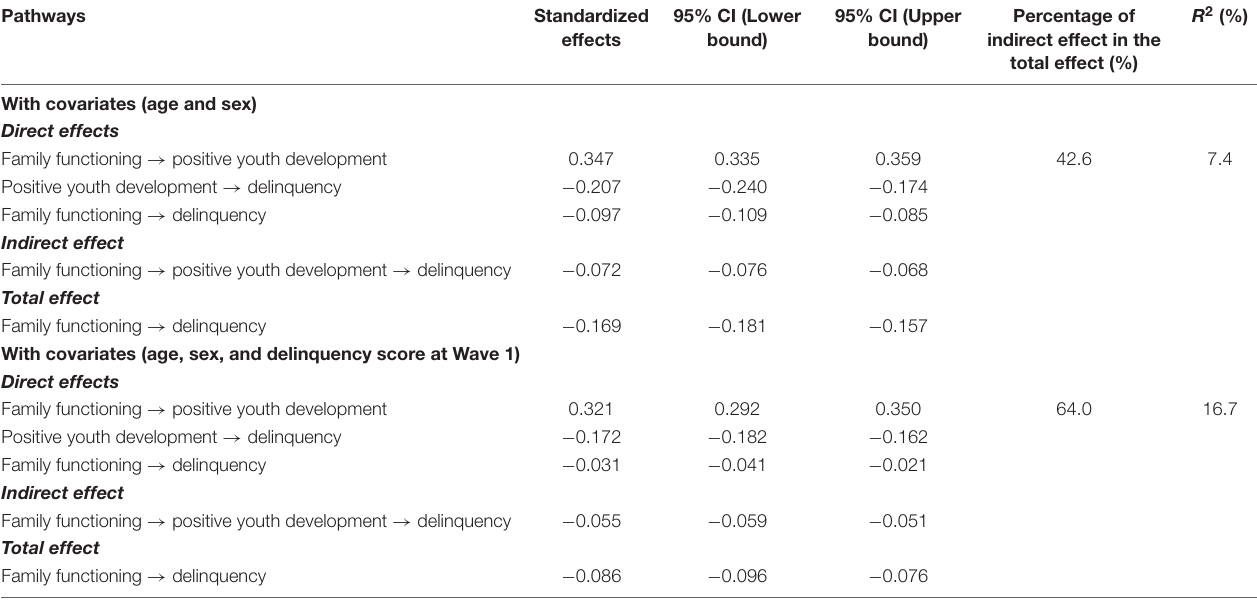
TABLE 2 | Results of mediation analyses with covariates ( N = 4,922).